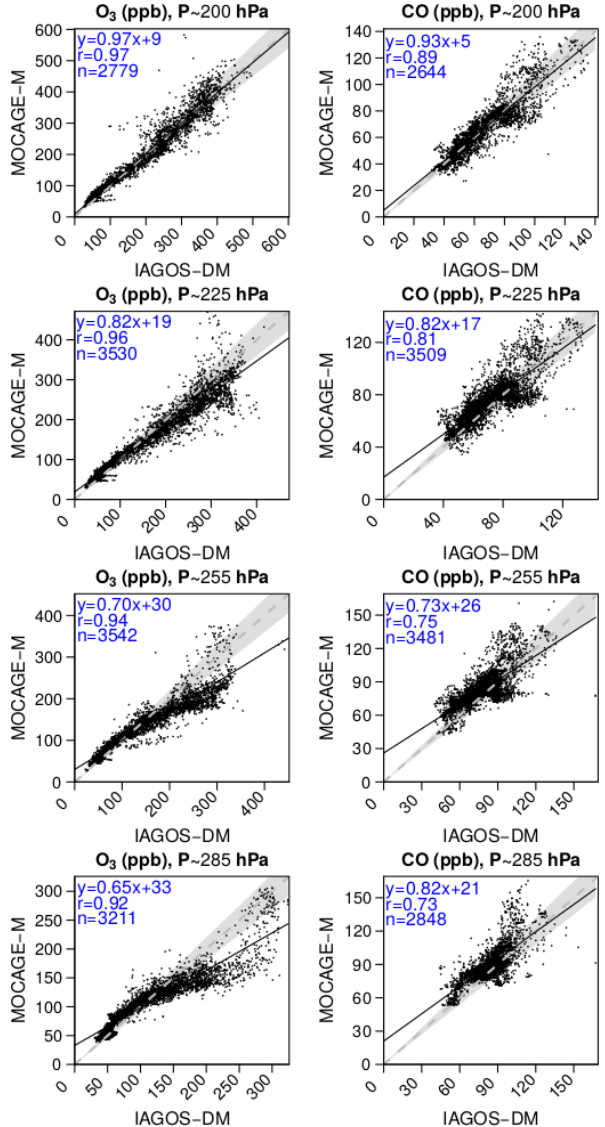
Figure 5. Scatterplots comparing the yearly mixing ratios from MOCAGE-M and IAGOS-DM, for O 3 (left panels) and CO (right panels), at each vertical grid level. The linear regression fit is rep- resented by the solid black line. The dashed grey line represents the y = x reference line, and the shaded area corresponds to a 10% error. The regression coefficients and the amount of data ( n ) are written in the top-left corner of each panel.